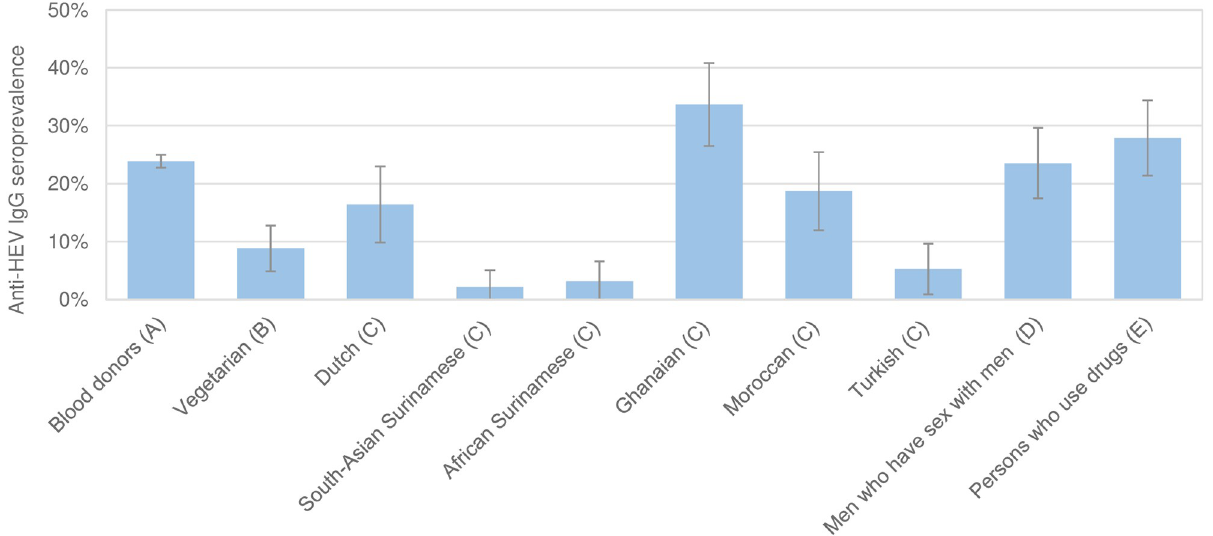
Fig 1. Anti-HEV IgG seroprevalence stratified by study population, corrected for age and gender. The letter presented behind the name of the group indicates the study population as described in the method section. The error bars depict the 95% confidence interval for the expected IgG HEV seroprevalence.